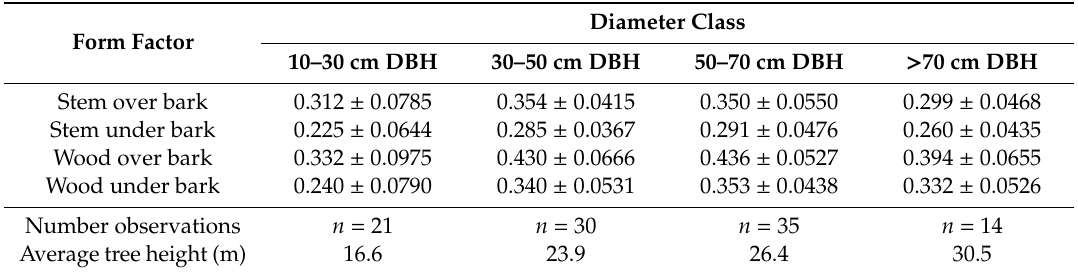
Table 3. Form factor by diameter class for stem and wood ( > 10 cm) and over and under bark.